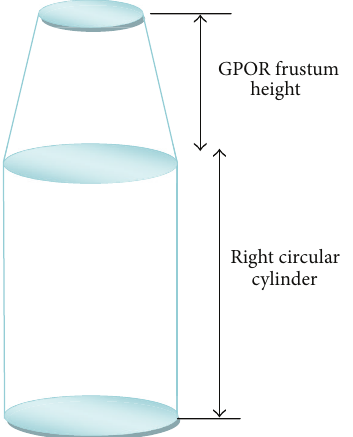
Figure 1: Schematic of the space